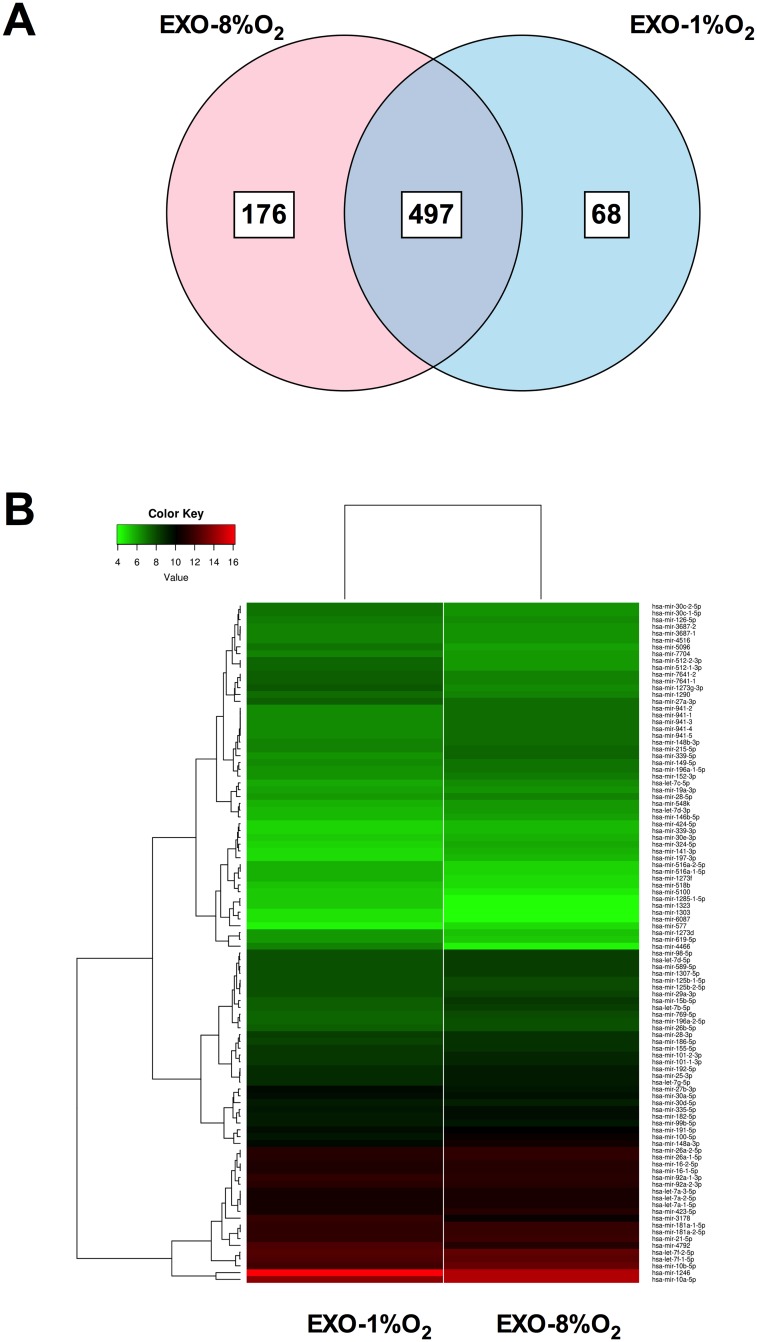
miRNA profile in EVT-derived exosomes under low oxygen tension.(A) The Venn diagram depicts the distribution of common and unique miRNA identified in exosomes released from EVT exposed to 1% and 8% oxygen. (B) Top 100 abundant miRNAs classified by normalised counts (see Methods) identified in exosomes isolated from EVT cells cultured under 1% or 8% oxygen. Hierarchical clustering of deep sequencing data was performed across exosomal miRNA samples. Normalisation of the reads was performed by DESeq2 using factors derived from the media ratio method.